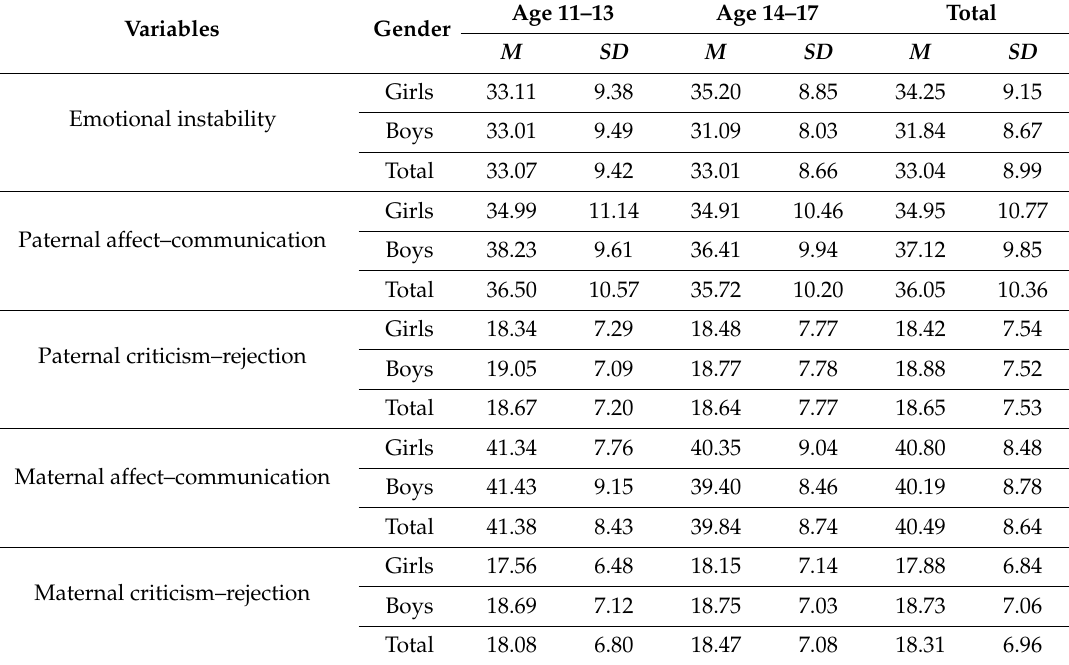
Table 1. Descriptive data for emotional instability and the factors of the EA-H scale for age and gender groups.